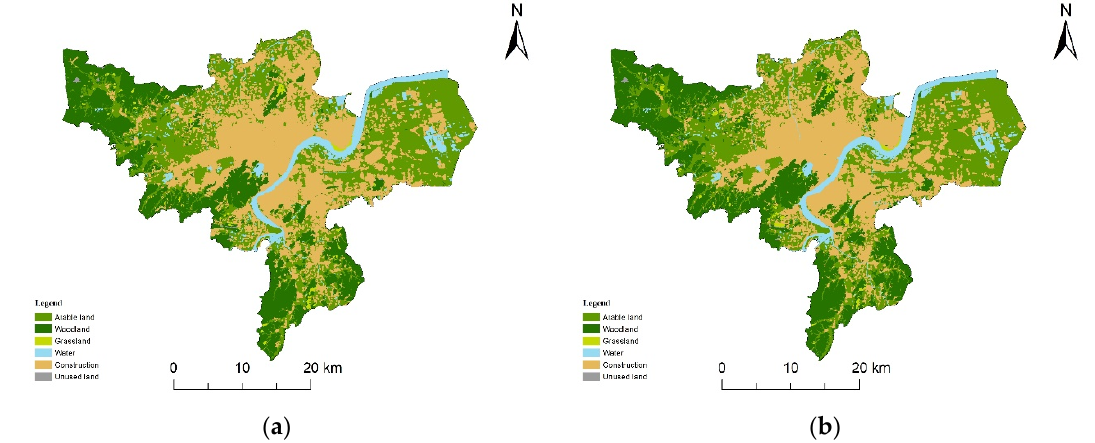
Figure 7. Land use data in 2030 under different scenarios: ( a ) natural development scenario; ( b ) ecological security scenario. Table 4. Indicator changes in construction land expansion in 2000, 2010, and 2018.